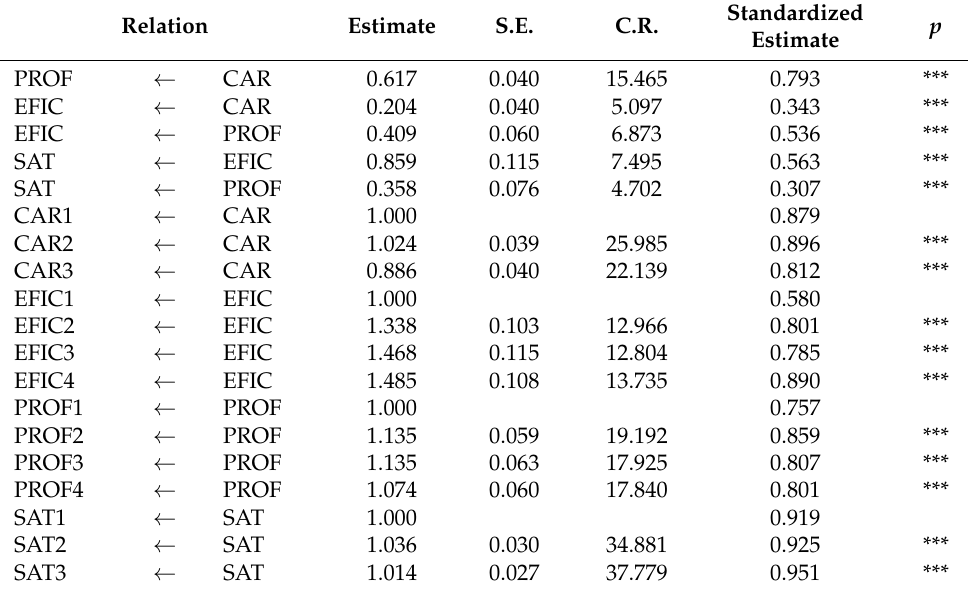
Table 5. Parameter